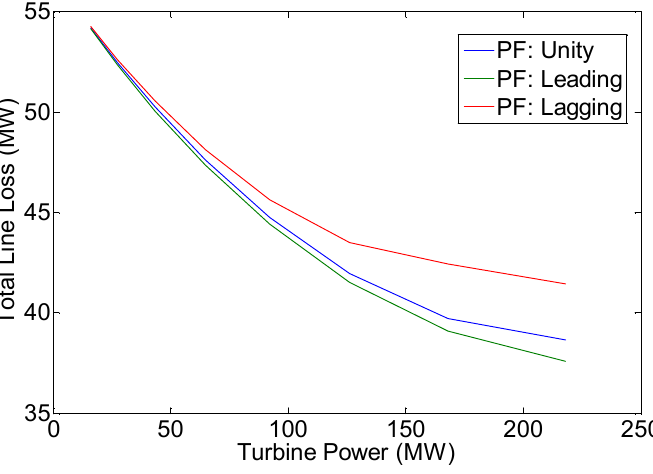
Figure 13. Variation of G1+G2+G3+G4+G5 active power output.